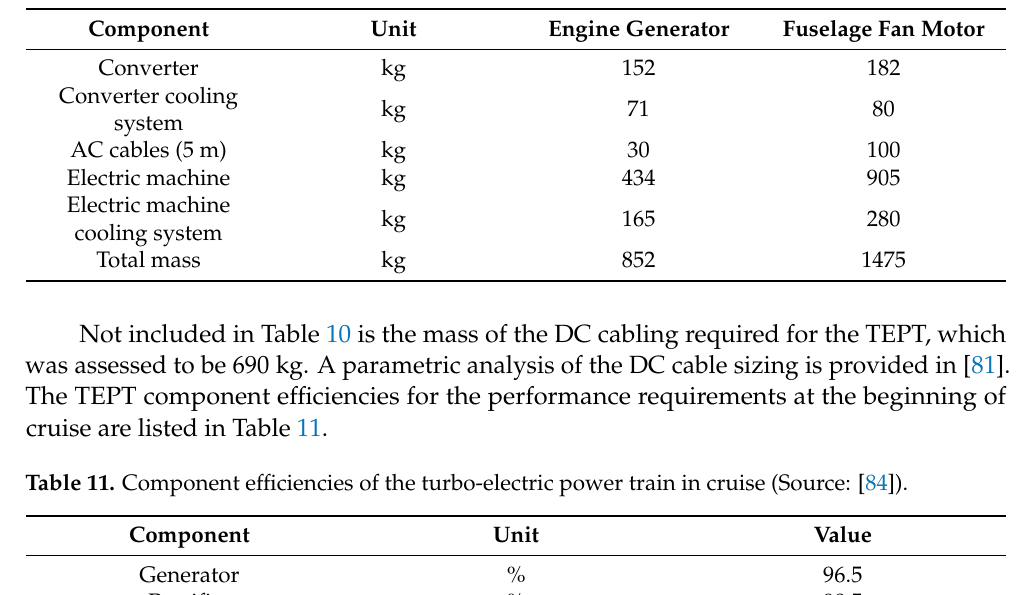
Table 11. Component efficiencies of the turbo-electric power train in cruise (Source: [84]). Component Unit Value Generator % 96.5 Rectifier % 98.5 Inverter 99.0 Motor 96.5 Total system